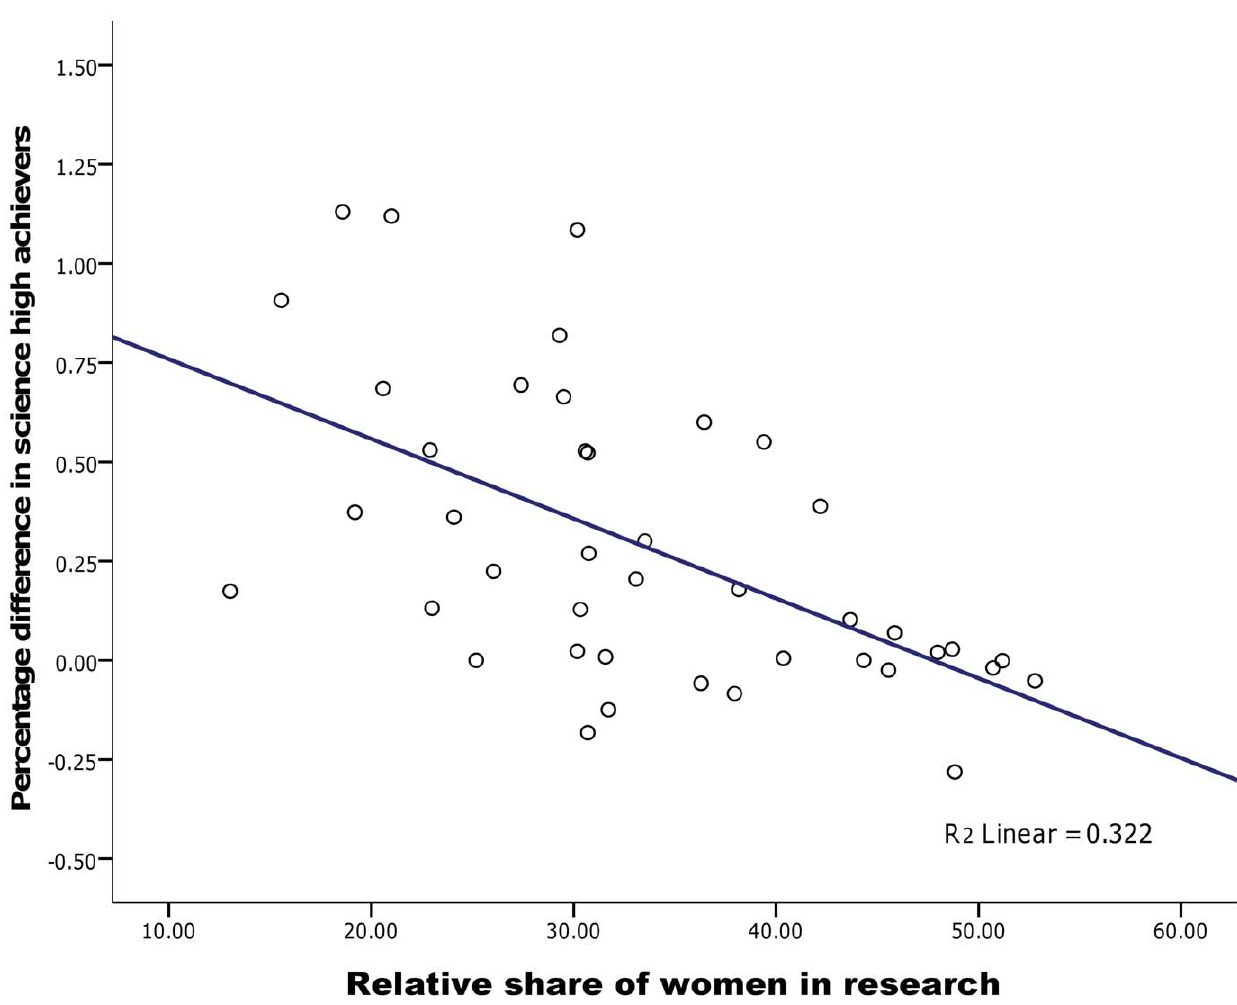
Figure 5. Relationship between women in research and gender ratios of high-achievers in science literacy.